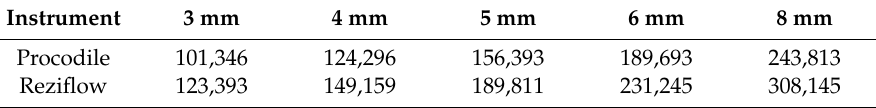
Table 2. Cross-section area (µm 2 ) of Procodile and Reziflow at different levels from the tip to the shaft.